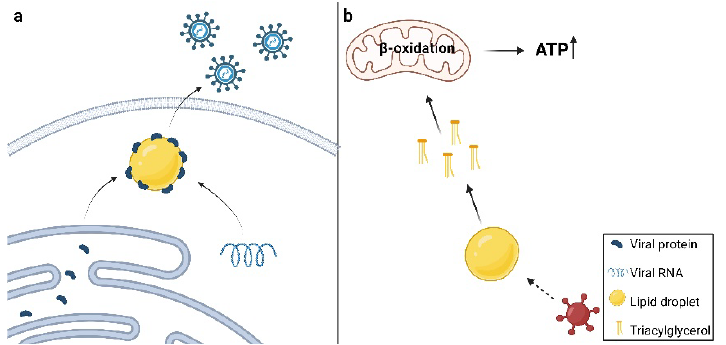
Figure 3. Roles of lipid droplets in viral replication. ( a ) Lipid droplets (LDs) serve as storage for viral proteins. After their synthesis in the endoplasmic reticulum, viral proteins are gathered at LDs. ( b ) LDs serve as a source of energy during viral replication. Some viruses use lipids stored in LDs for energy production. Viral infection induces the release of triglycerides (TAGs) from LDs, which are transported into the mitochondria, where they undergo lipolysis known as β -oxidation and produce large amounts of ATP needed for viral replication. Created with BioRender.com.